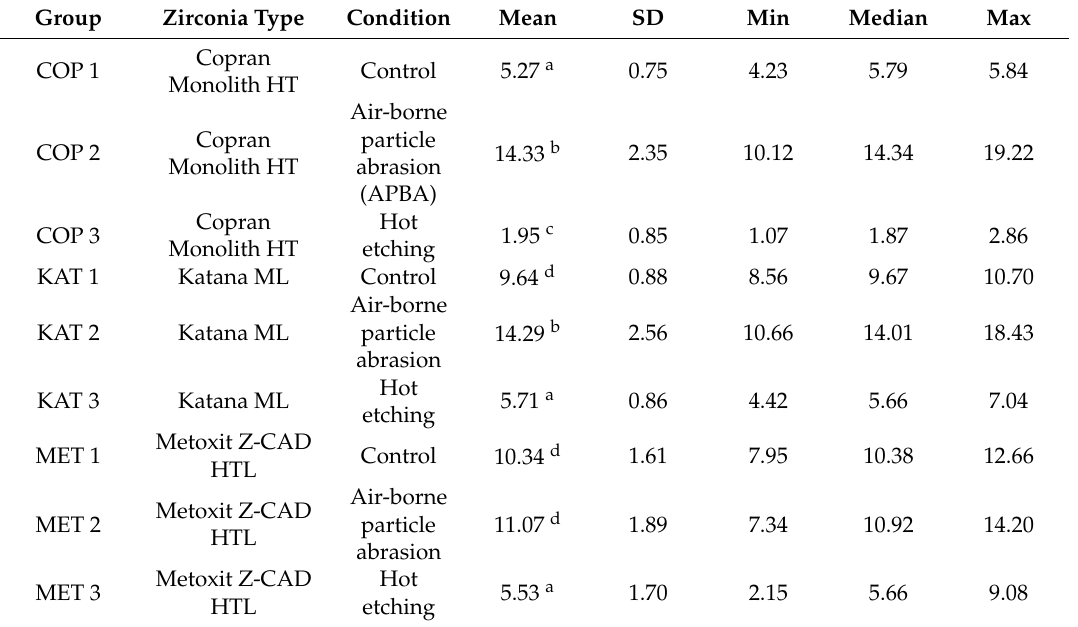
Table 3. Descriptive statistics (MPa) of the di ff erent groups. SD: standard deviation; Min: minimum value; Mdn: median; Max: maximum value. Superscript letters (a, b, c, and d) are used to indicate statistical results: di ff erent letters indicate the presence of significant di ff erences in shear bond strength among the groups (significance was set at p <